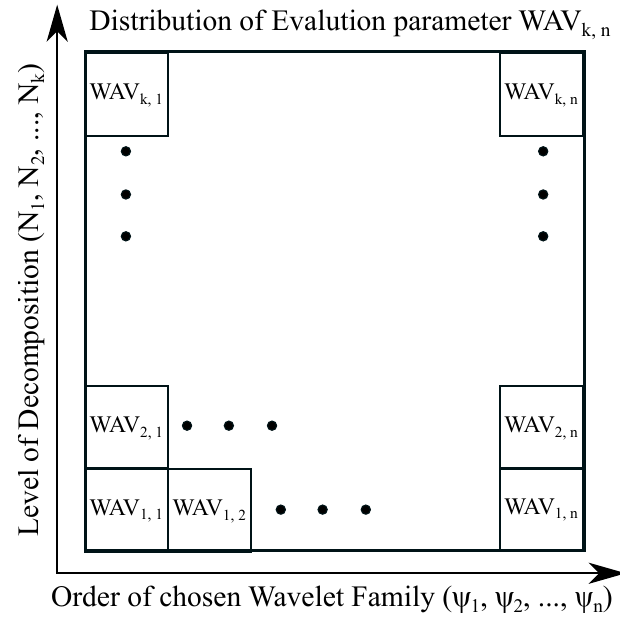
Figure 6. A general Scheme of spatial modelling for 2D distribution of Wavelet response.